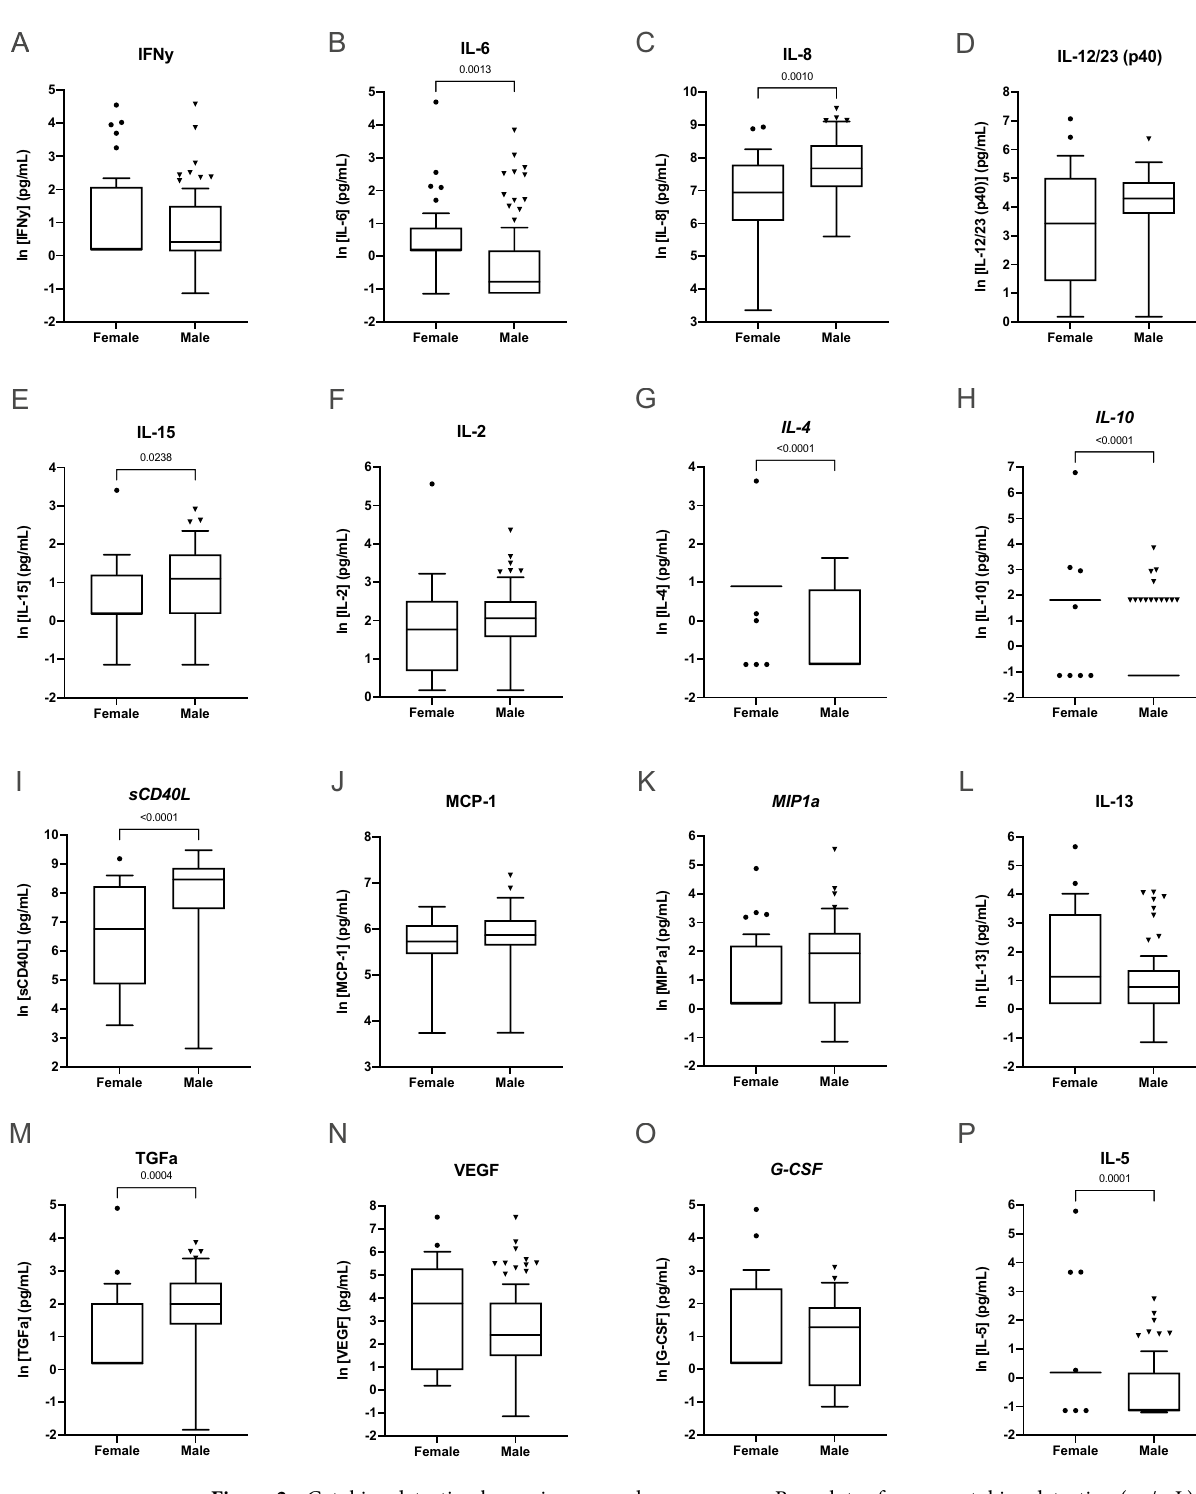
Figure 2. Cytokine detection by sex in cynomolgus macaques. Box-plots of serum cytokine detection (pg/mL) in female and male cynomolgus macaques. Whiskers on box-plots were calculated using the Tukey method. P-values representing significant group differences were calculated based on non-parametric, unpaired two-way Mann–Whitney tests. Regular title = accept; italicized title =